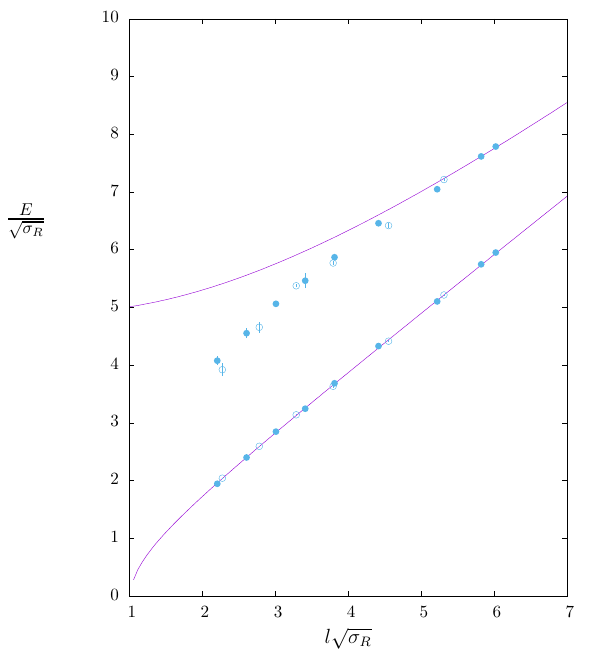
Figure 8 . Energies of the lightest two winding (cid:13)ux tubes of length l on spatial volumes l (cid:2) l ? with l ? (cid:29) l for small l . For SU(4) ( (cid:15) ) and SO(6) ( (cid:14) ), scaled by (cid:27) R = (cid:27) 2 A and (cid:27) R = (cid:27) f respectively. Lines are ‘Nambu-Goto’